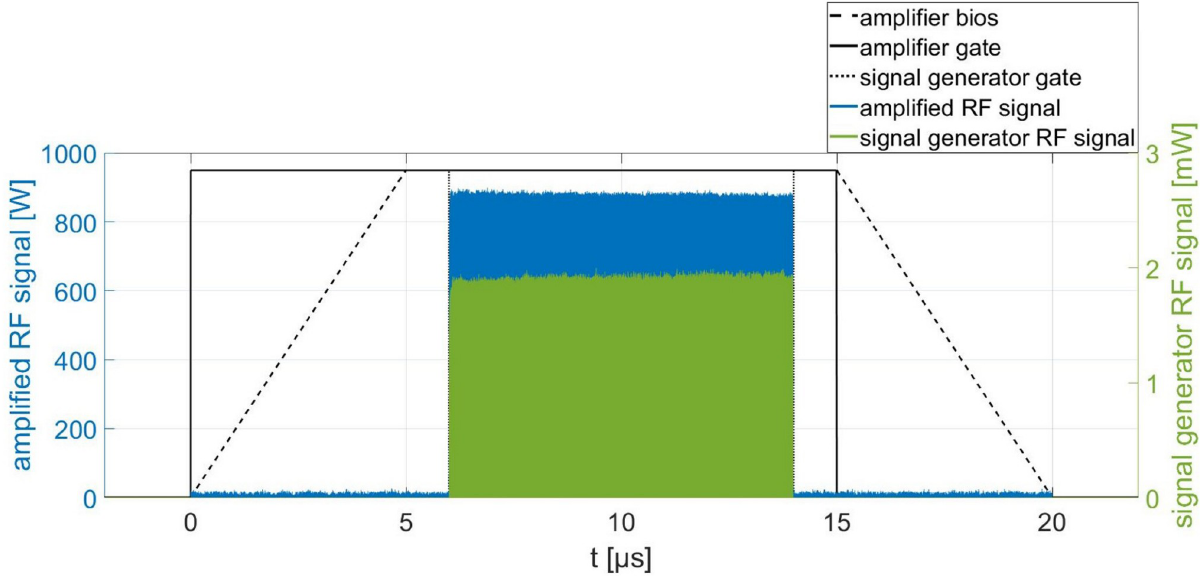
Fig 9. Signal characteristics of the RF system. Schematic: gate generator signal and amplifier bias. The time offset between amplified signal and generator signal is corrected for illustration purposes.